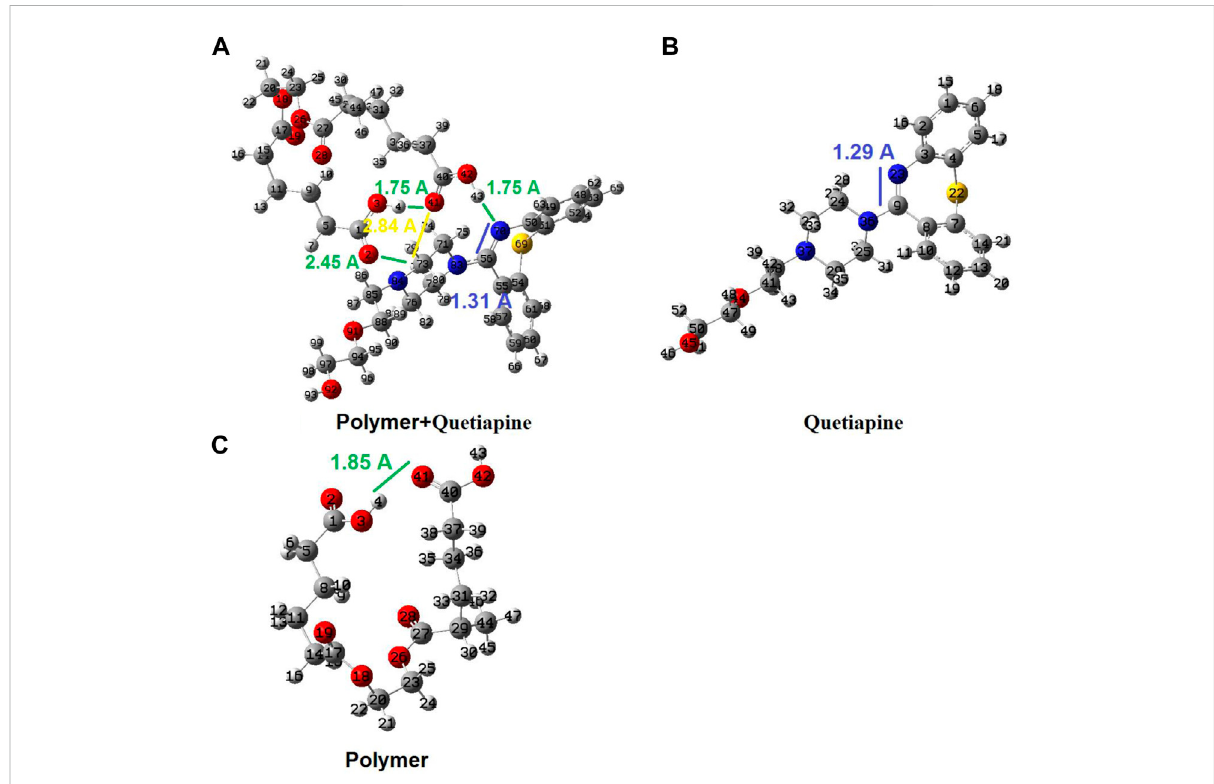
FIGURE 7 Geometrical structures for the isolated polymer, isolated quetiapine (drug), and the complex of the polymer – quetiapine system optimized by quantum chemical calculations.